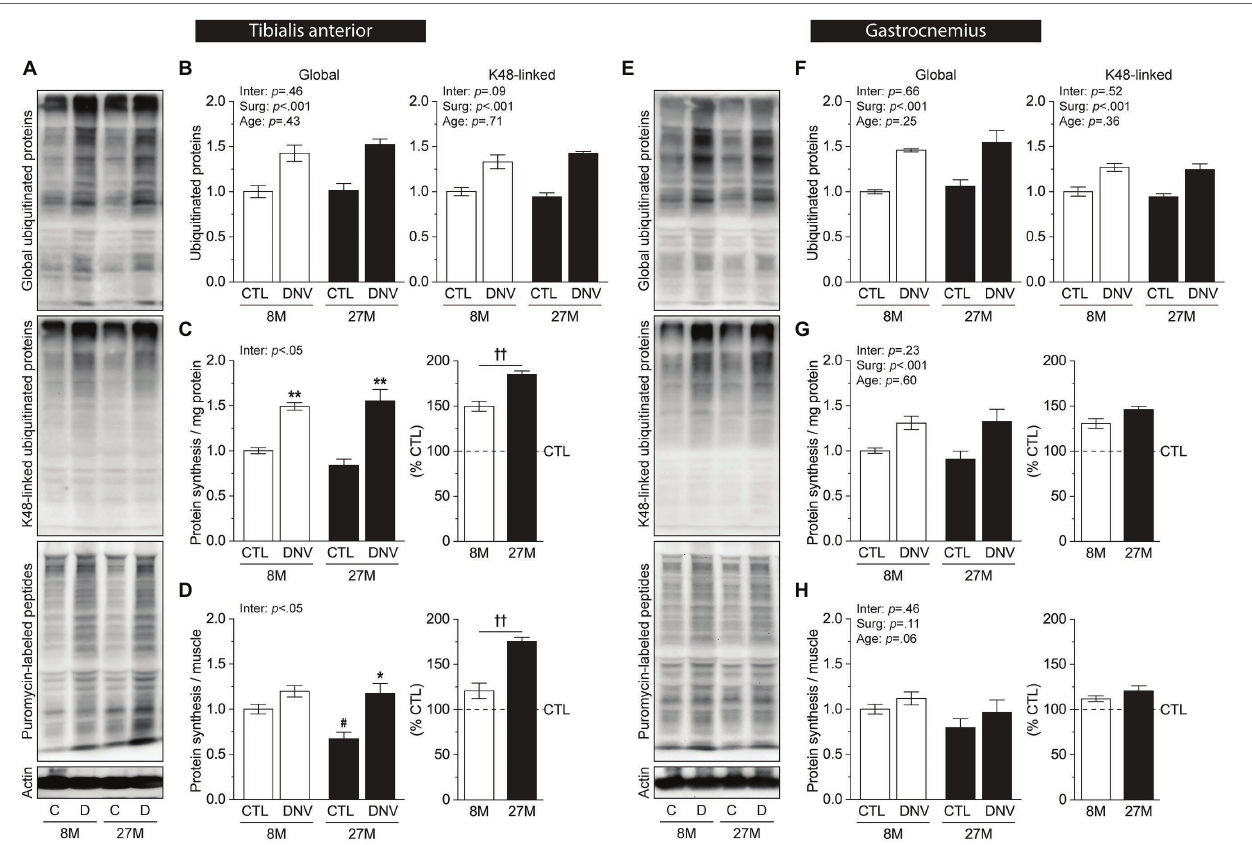
FIGURE 2 | Effects of aging on protein synthesis during muscle denervation. Mice at 8 months (8 M) and 27 months (27 M) of age were subjected to denervation (right leg, DNV) and sham (contralateral left leg, CTL) surgeries, and TA and GAST muscles were collected 7 days post-surgeries with puromycin injection. (A) Representative Western blots of TA samples. (B–D) Quantification of ubiquitinated proteins (B) and puromycin-labeled peptides per mg protein (C) or per muscle (D) in TA. (E) Representative Western blots of GAST samples. (F–H) Quantification of ubiquitinated proteins (F) and puromycin-labeled peptides per mg protein (G) or per muscle (H) in GAST. n = 4–3 mice/group. Data are presented as mean ± SEM. and expressed relative to 8 M/CTL or as % of CTL (right panels in C,D,G,H ). * p < 0.05 and ** p < 0.01 vs. CTL by two-way mixed ANOVA. # p < 0.05 vs. 8 M within the same surgery groups by two-way mixed ANOVA. †† p < 0.01 by unpaired t test. Inter, interaction between surgery effects (Surg) and age effects by two-way mixed